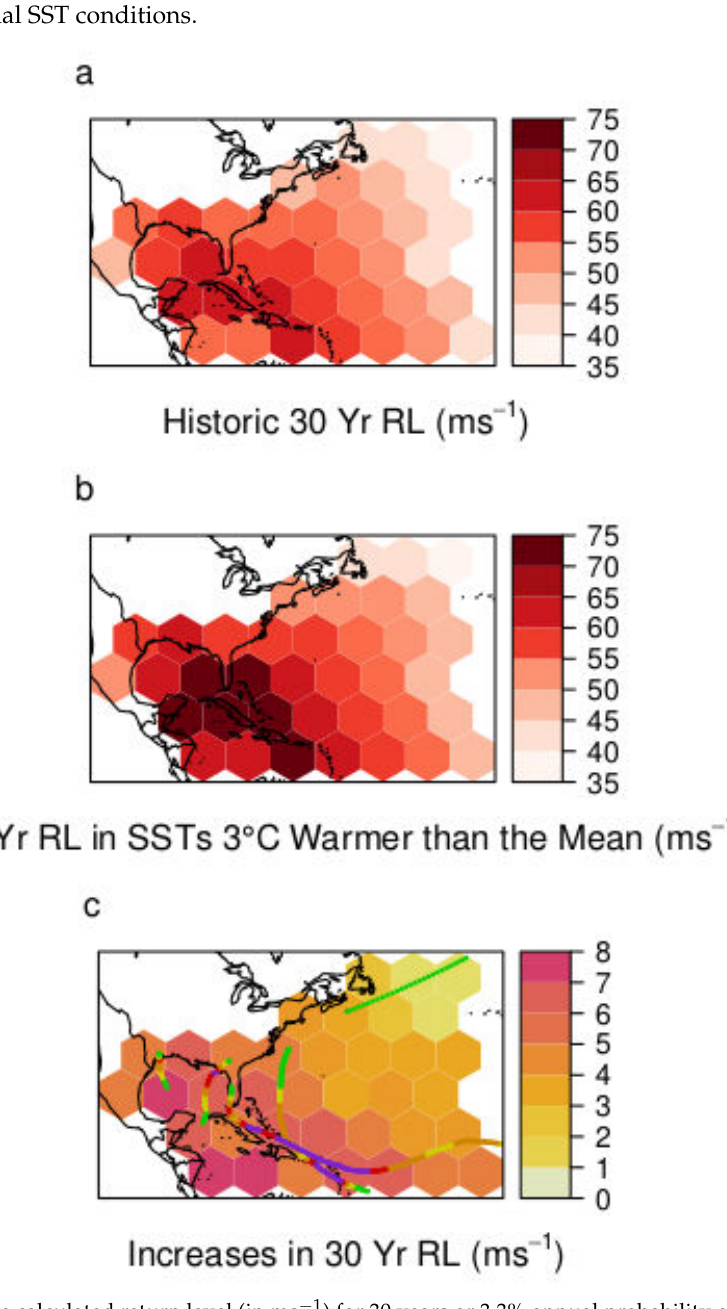
Figure 7. ( a ) The calculated return level (in ms − 1 ) for 30 years or 3.3% annual probability of occurrence using historic data and the average relationship between maximum wind and SSTs. ( b ) The calculated return level for 30 years using the increased maximum wind speeds based on local sensitivity to SST. ( c ) The difference between historic and future return levels. Tracks from Hurricanes Harvey, Irma, and Maria from 2017 and Hurricane Michael from 2018 are included and color coded based on